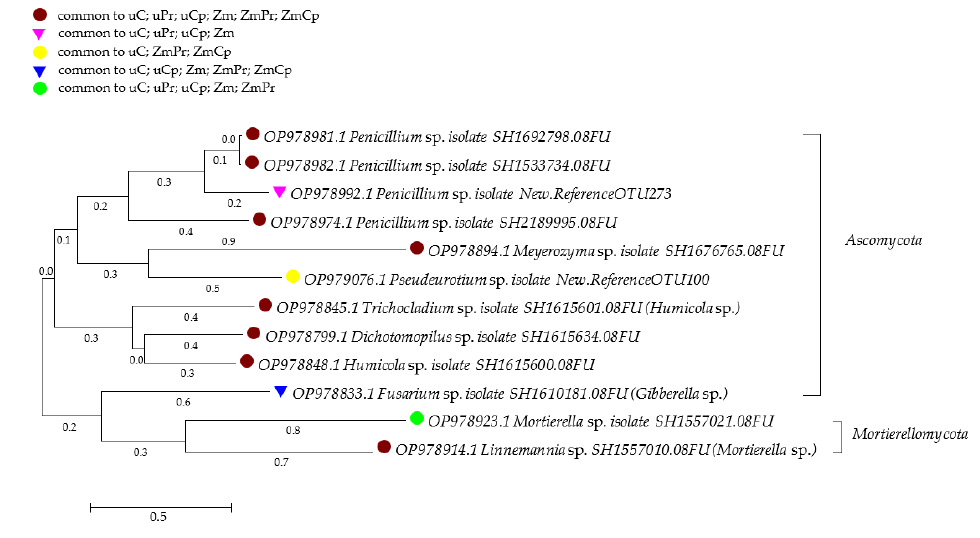
Figure 12. Phylogenetic tree of fungi isolated from the soil by the neighbor-joining method. uC — contaminated unsown soil; uPr — sown soil contaminated with permethrin; uCp — sown soil contaminated with cypermethrin; ZmC — uncontaminated soil sown with Zea mays ; ZmPr — soil sown with Zea mays contaminated with permethrin; ZmCp — soil sown with Zea mays contaminated with cypermethrin.